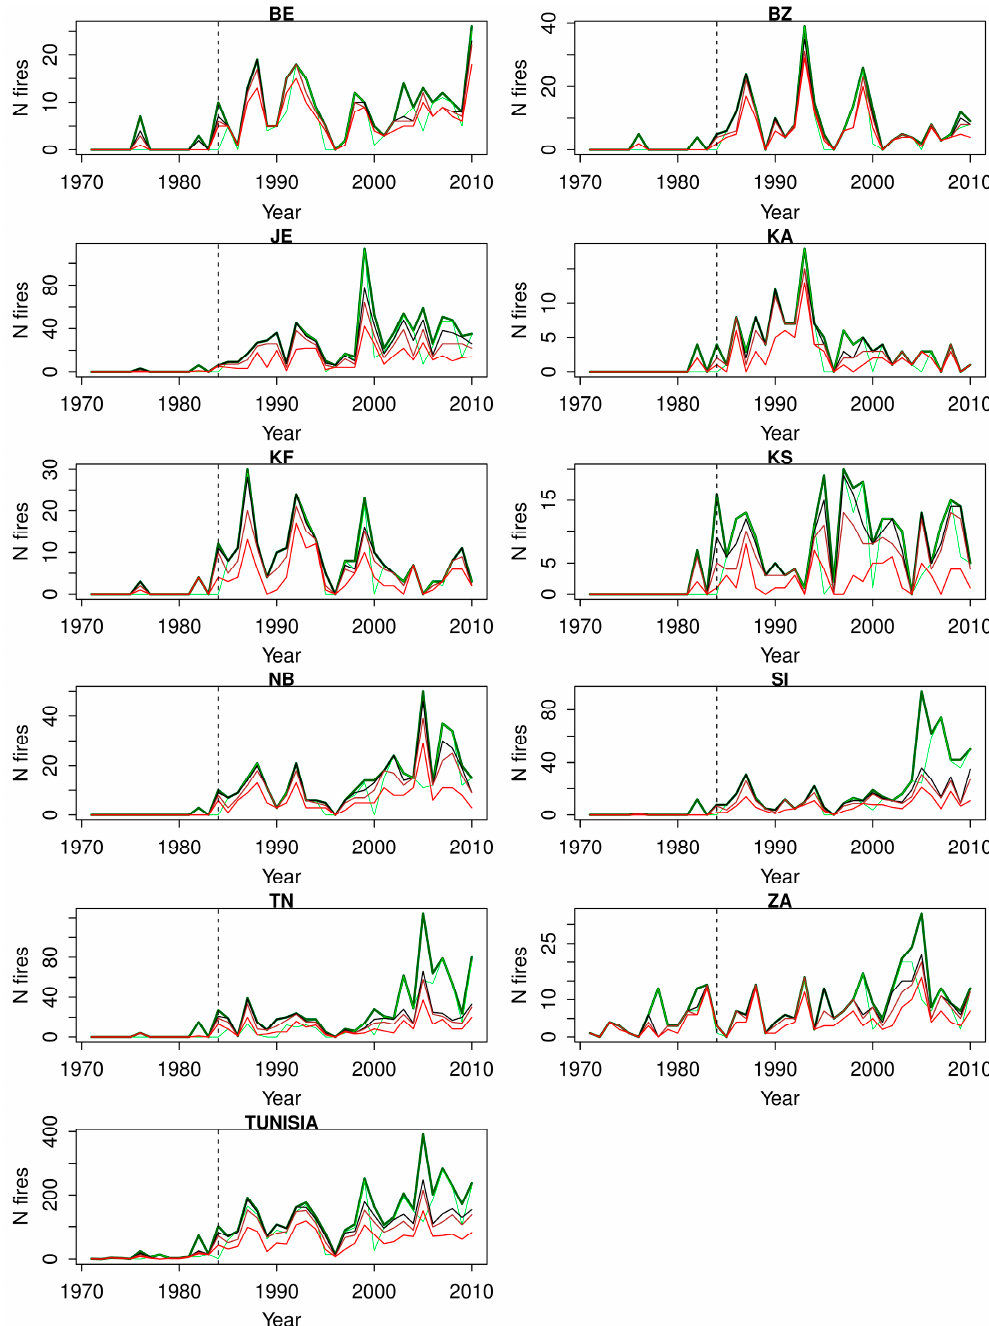
Figure 3. For each gouvernorat and the whole Tunisia, yearly fire numbers from the raw DGF database (thin green line), the assembled database COR-1 (thick green line) and fire numbers from COR-1 filtered for Forest and Shrublands (no agricultural, nor herbaceous fires) for fire sizes >1 ha (red line), 0.1 ha (brown line) and all fires (black line). BE: Beja; BZ: Bizerte; JE: Jendouba; KA: Kairouan, KF: Le Kef; KS: Kasserine; NB: Nabeul; SI: Silina; TN: Tunis; ZA: Zaghouan.